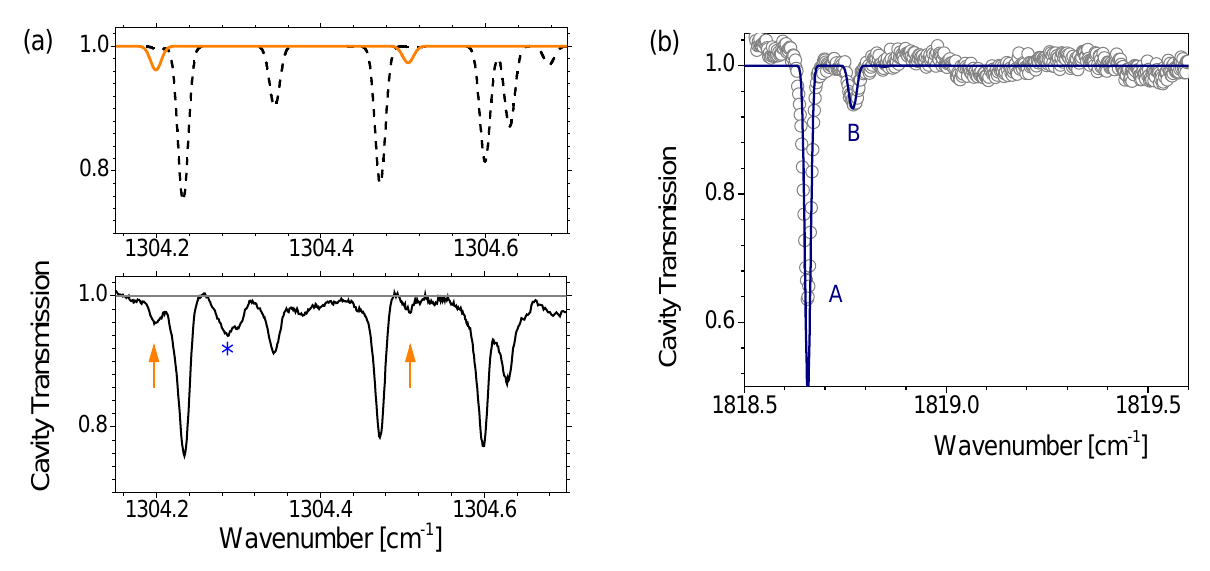
Figure 14. (a) Transmission spectrum obtained by cw-QCL-CEAS spectrometer mounted on the MW reactor in Figure 13a. Molecular absorption lines were detected in-situ in a 395( + 25)/10/10 sccm Ar(+ purge)/CH /N plasma (1.5 mbar total pressure, 1.5 kW): The 4 2 HCN lines, P 34 e and P 38, are indicated by arrows. Potential H O absorption is marked 2 with *. Strong CH lines would require a correction (not within the weak absorption limit). 4 Upper: Calculation of a transmission spectrum for CH (400 K, dotted trace) and HCN 4 (1200 K, solid trace). Since the gas temperature (gradient) and thus number density (gradients) are unknown this plot should be regarded as a guide to the eye for identifying the main features in the lower panel. (b) CEAS spectrum of NO (experimental -